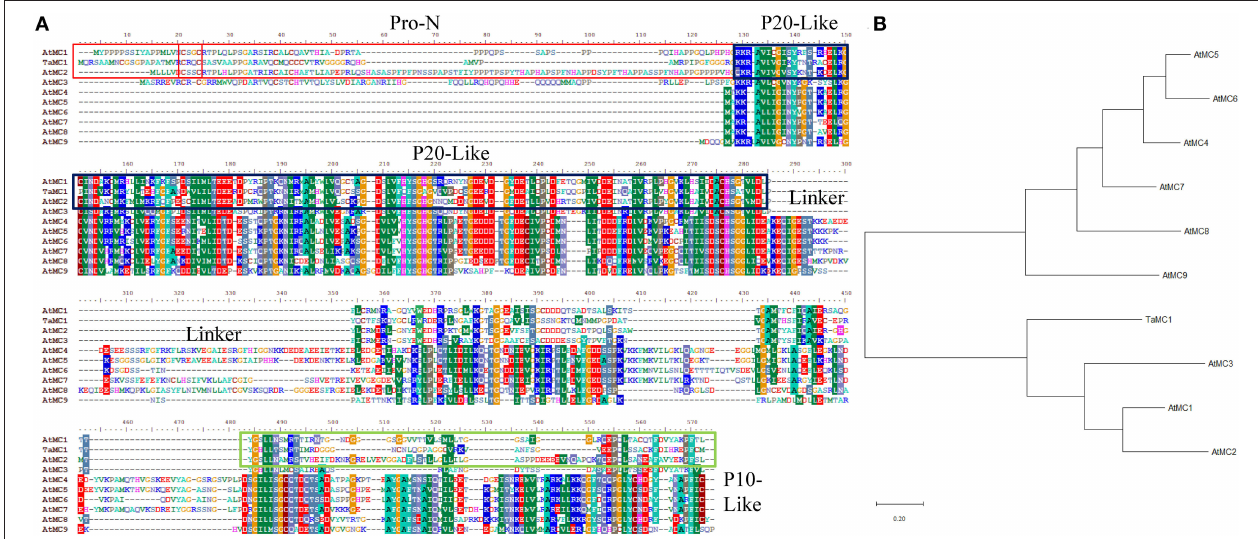
FIGURE 1 | Sequence analysis of TaMCA-Id . (A) Multi-sequence alignment of TaMCA-Id with other metacaspase proteins from Arabidopsis . Amino acid sequences from 10 metacaspase share similar structures, containing Pro-N domain, P20-like domain, Linker, and P10-like domain. Ta , Triticum aestivum L.; At , Arabidopsis thaliana . (B) Phylogenetic analysis of TaMCA-Id . TaMCA-Id and function-known metacaspase in Arabidopsis thaliana (At) are used to construct their phylogenetic tree using MEGA-X software. TaMC1 in the figure indicates TaMCA-Id. AtMC1 to AtMC9 in the figure indicate AtMCA1 to AtMCA9, respectively.